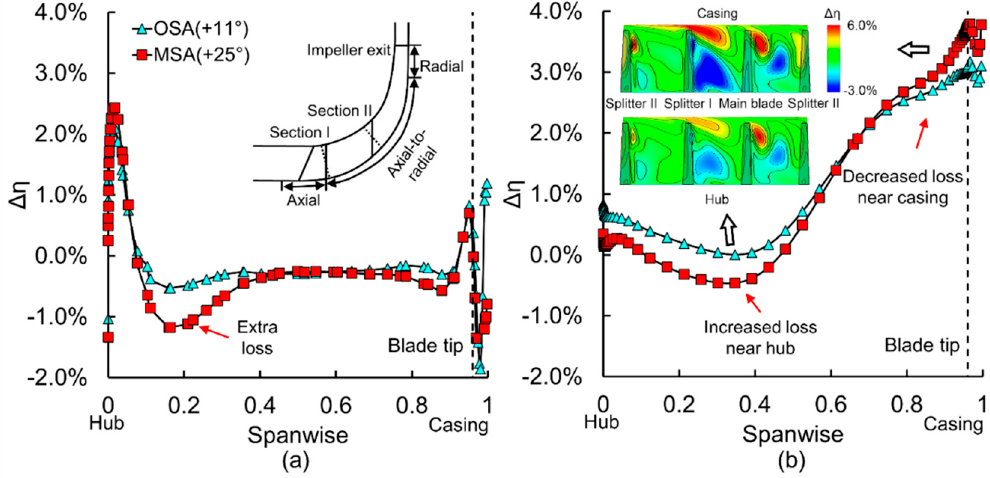
Figure 12. Spanwise pitch-averaged efficiency deviation distribution at ( a ) Section I and ( b ) impeller exit.